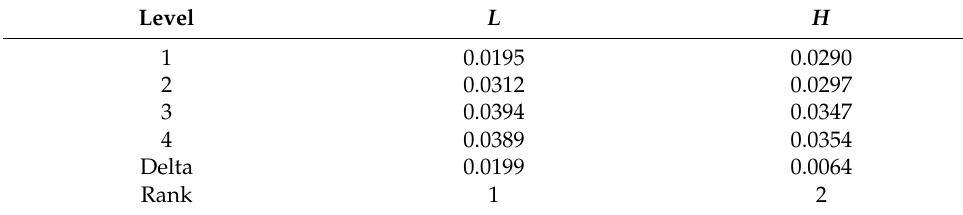
Table 6. Mean response